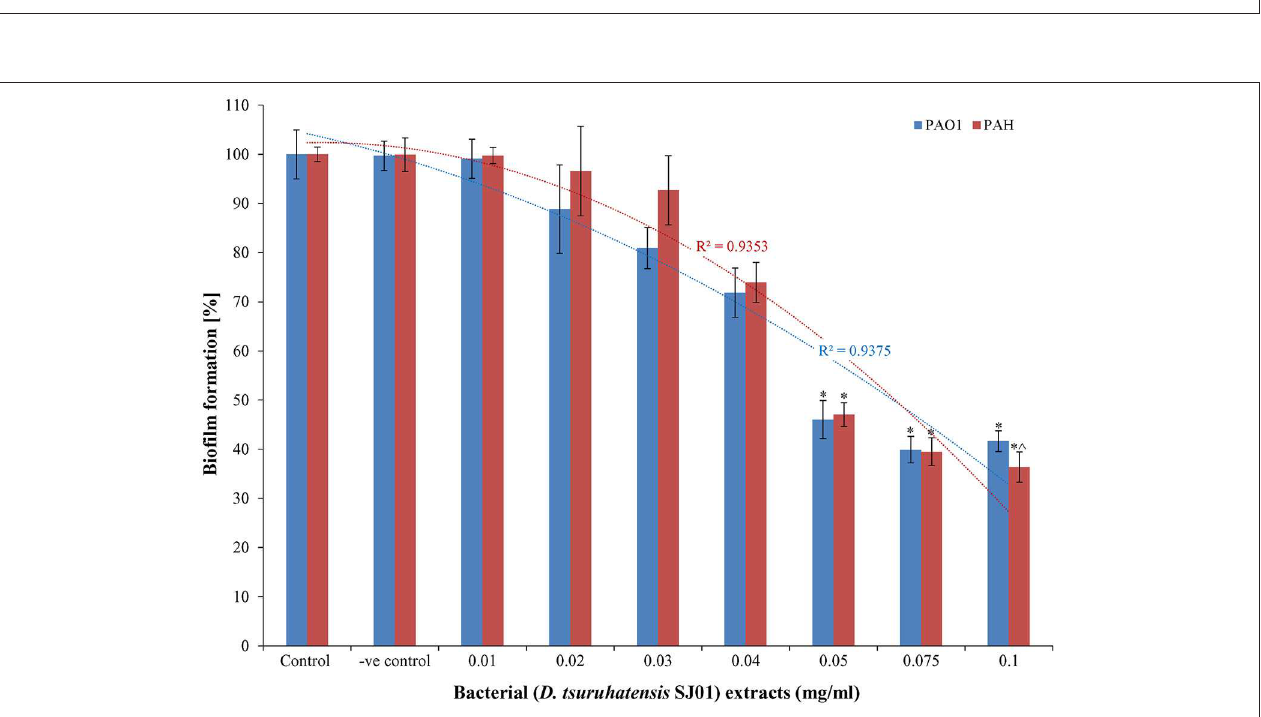
FIGURE 3 | The antibiofilm activity of D. tsuruhatensis SJ01 extract. Different concentration of bacterial extracts (0.01 − 0.1 mg/ml) was tested against wild-type, widely used biofilm forming reference strain P. aeruginosa strains. Tests without extract and with methanol were considered as control and negative control, respectively. *Indicates significant differences from the control at P < 0.05 and ∧ indicates maximum significant differences from the control at P < 0.05 .